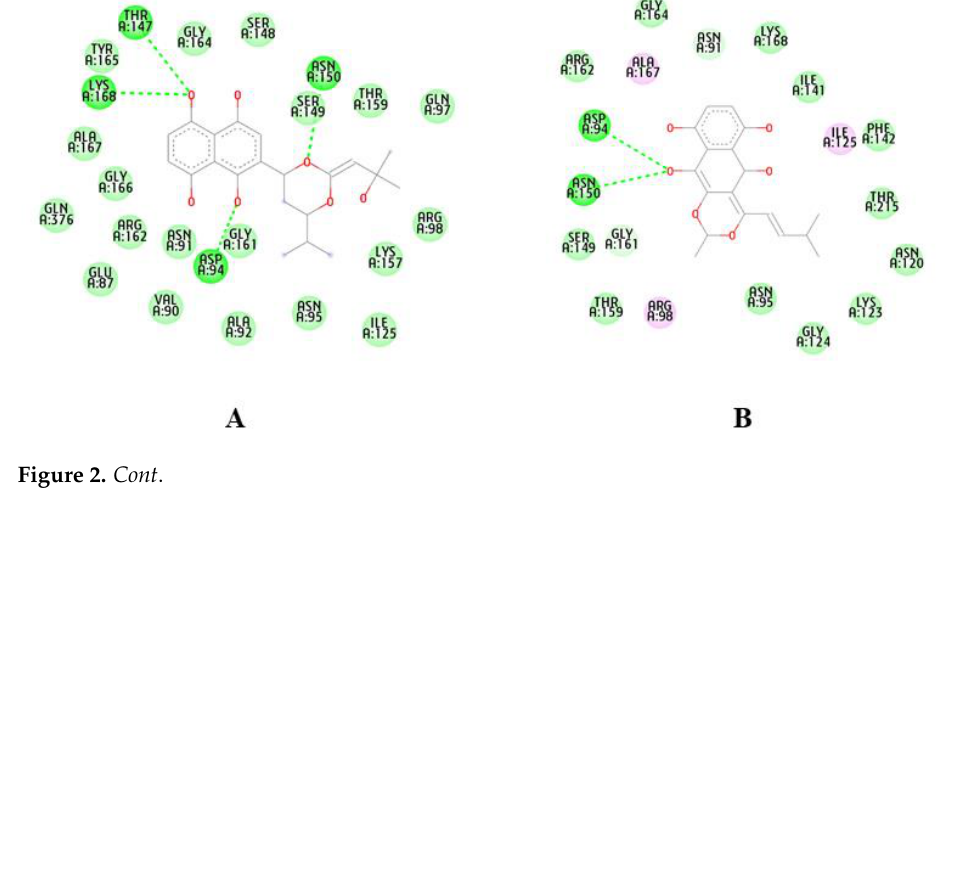
Figure 2. The 2D representations of intramolecular interactions of compounds CP13 ( A ), CP14 ( B ), CP17 ( C ) and Isoeleutherin ( D ) with Topoisomerase II. 3. Material and Methods 3.1. Plant Material, Extract and Fractions The E. plicata bulbs were collected in Vila Fátima, a municipality of Traquateua in the state of Pará, Brazil (BR 318, Lat. 1.1436°, Long. 46.95511°) The botanical identification was deposited in the Herbarium João Murça Pires, of the Museu Paraense Emílio Goeldi under the registration MG. 202631. Subsequently, the bulbs were washed in running water, cut into smaller pieces and subjected to the drying process in a circulating air oven. After drying, they were ground in knife mills to obtain the powder and subjected to maceration